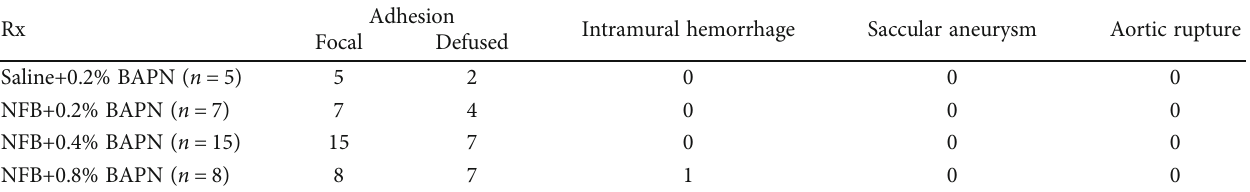
Note: pathology was not detected in descending